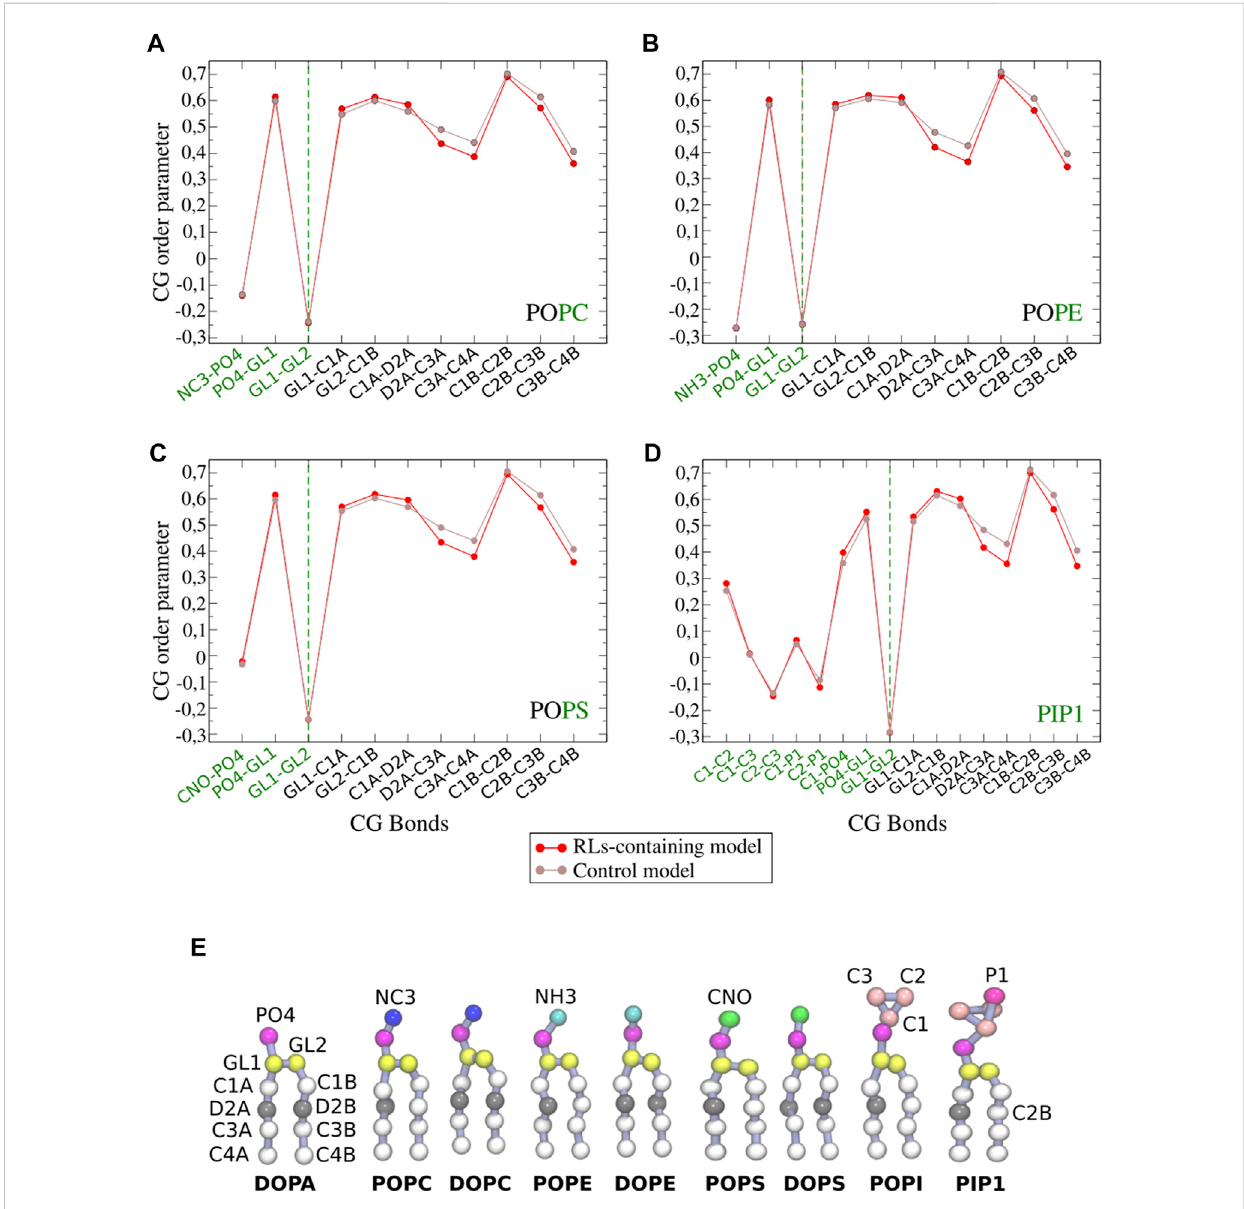
FIGURE 3 CGorderparametersofeachphospholipid (A – D) inmodel1(POPC/POPE/POPS/PIP1/ergosterol30/18/6/6/40)withandwithoutRLs(showninred andbrown, respectively).Bondsimpliedinmodelledpolar headsareshown ingreen (seeFigure 2Dfor CGbead names). (E) Structure ofphospholipidsin coarse grained